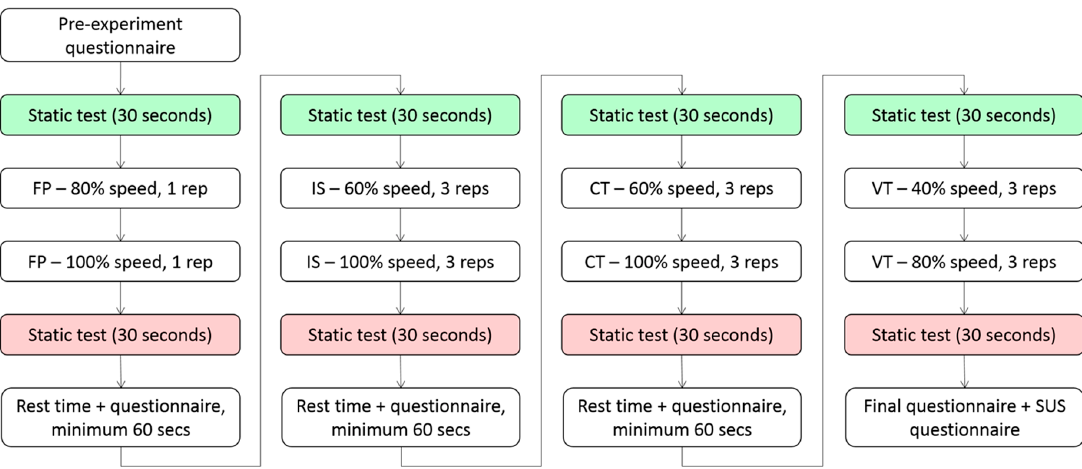
Figure 3. Flowchart illustrating the experiment’s execution. The green and red color represent the static tests executed after the resting phases and after completion of a task series, respectively.